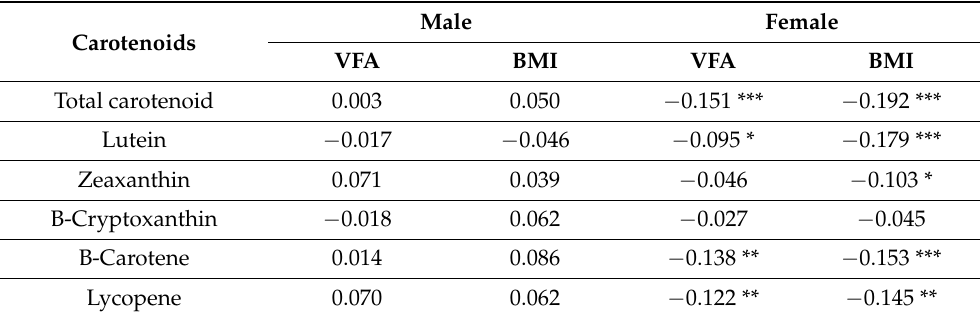
Table 2. Correlation coefficients between visceral fat area (VFA)/body-mass index (BMI) and carotenoids.